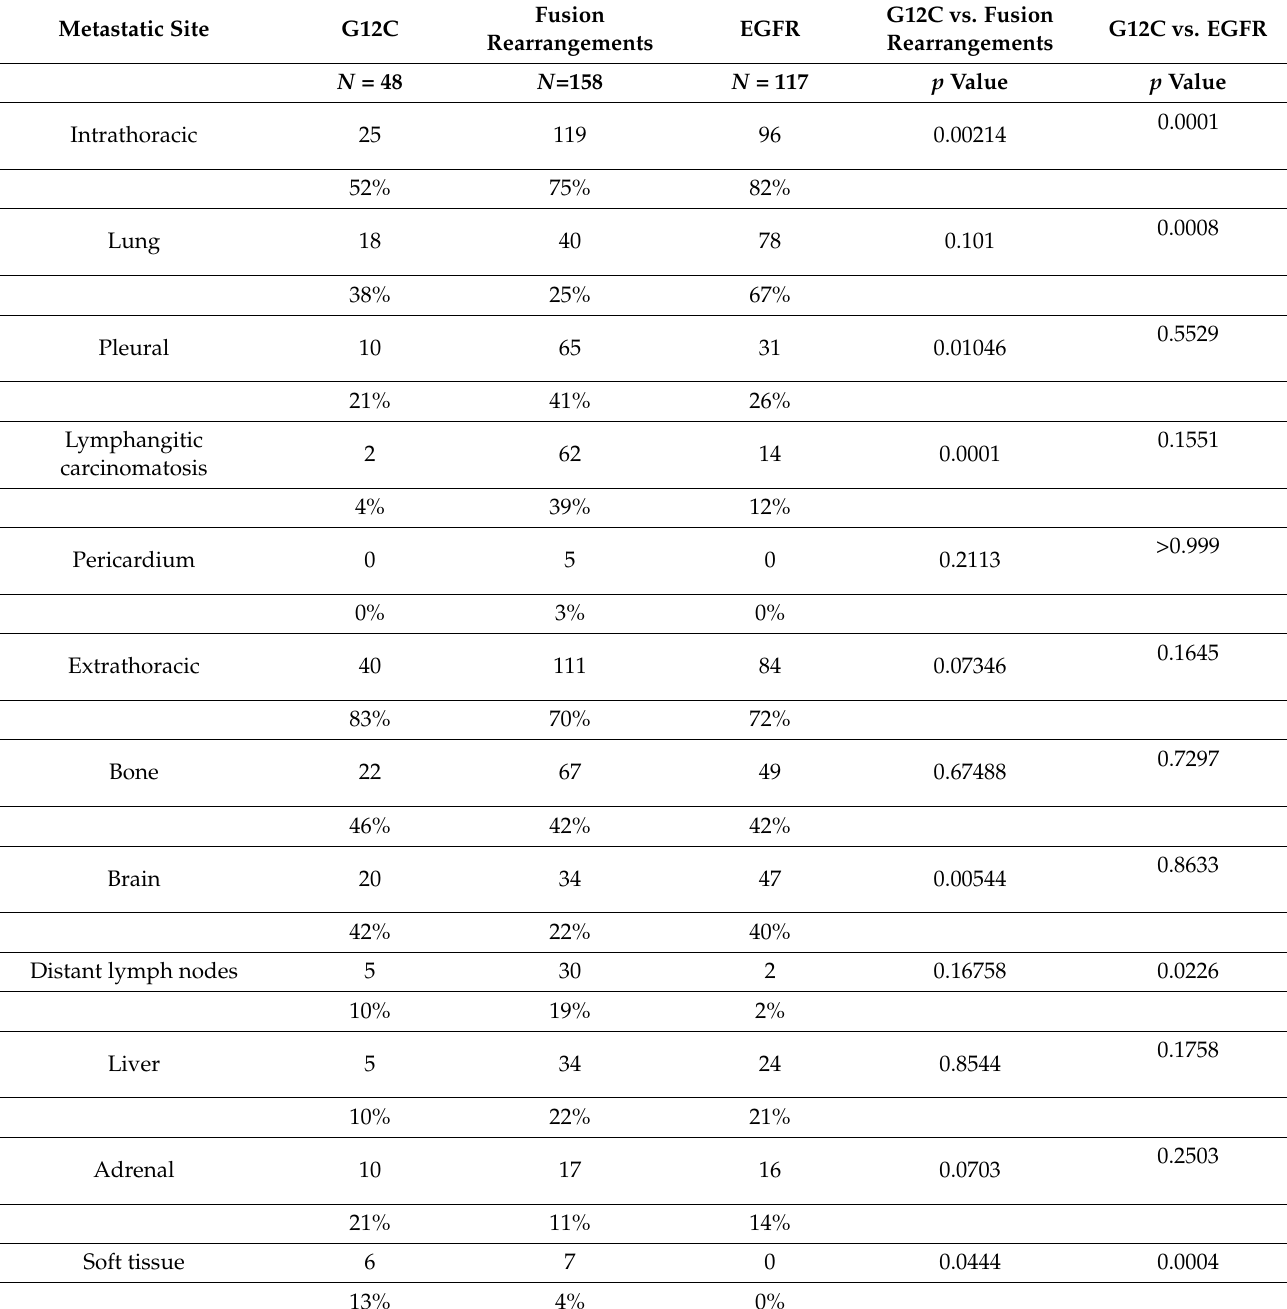
Table 6. Pattern of metastases in G12C KRAS and other targetable genetic alteration-driven NSCLC. Metastatic Site